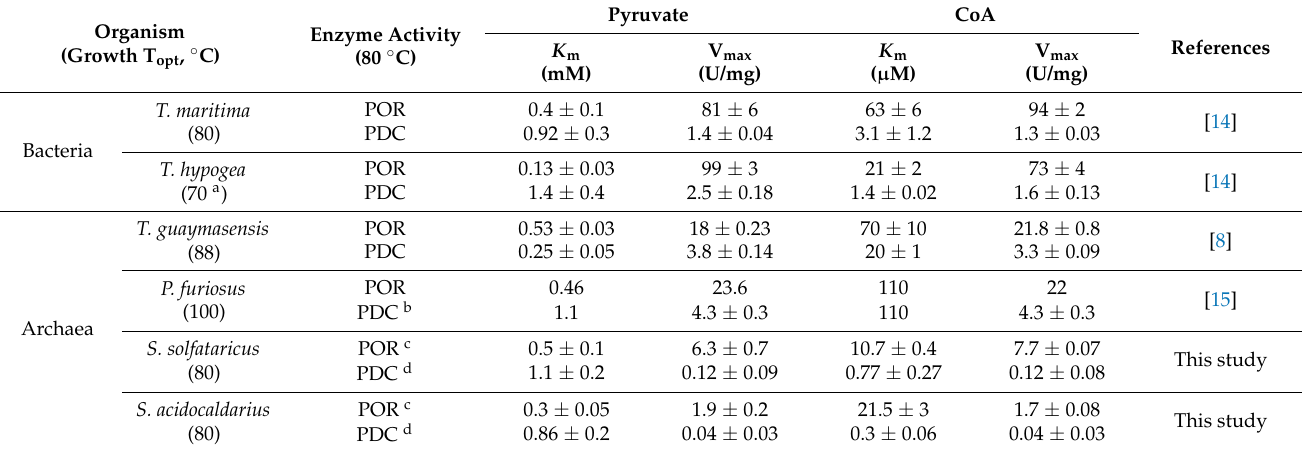
Table 4. Kinetic parameters of the POR and PDC activity of bifunctional POR/PDCs from